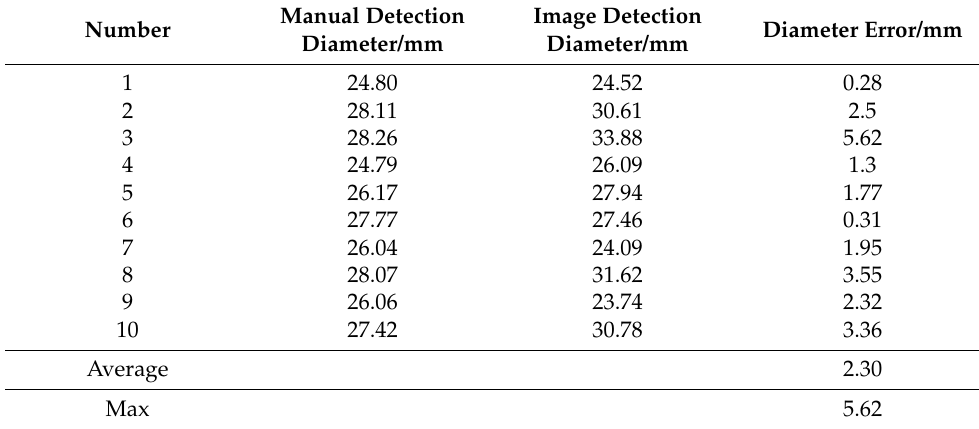
Table 3. Comparison of the test results of grape berry